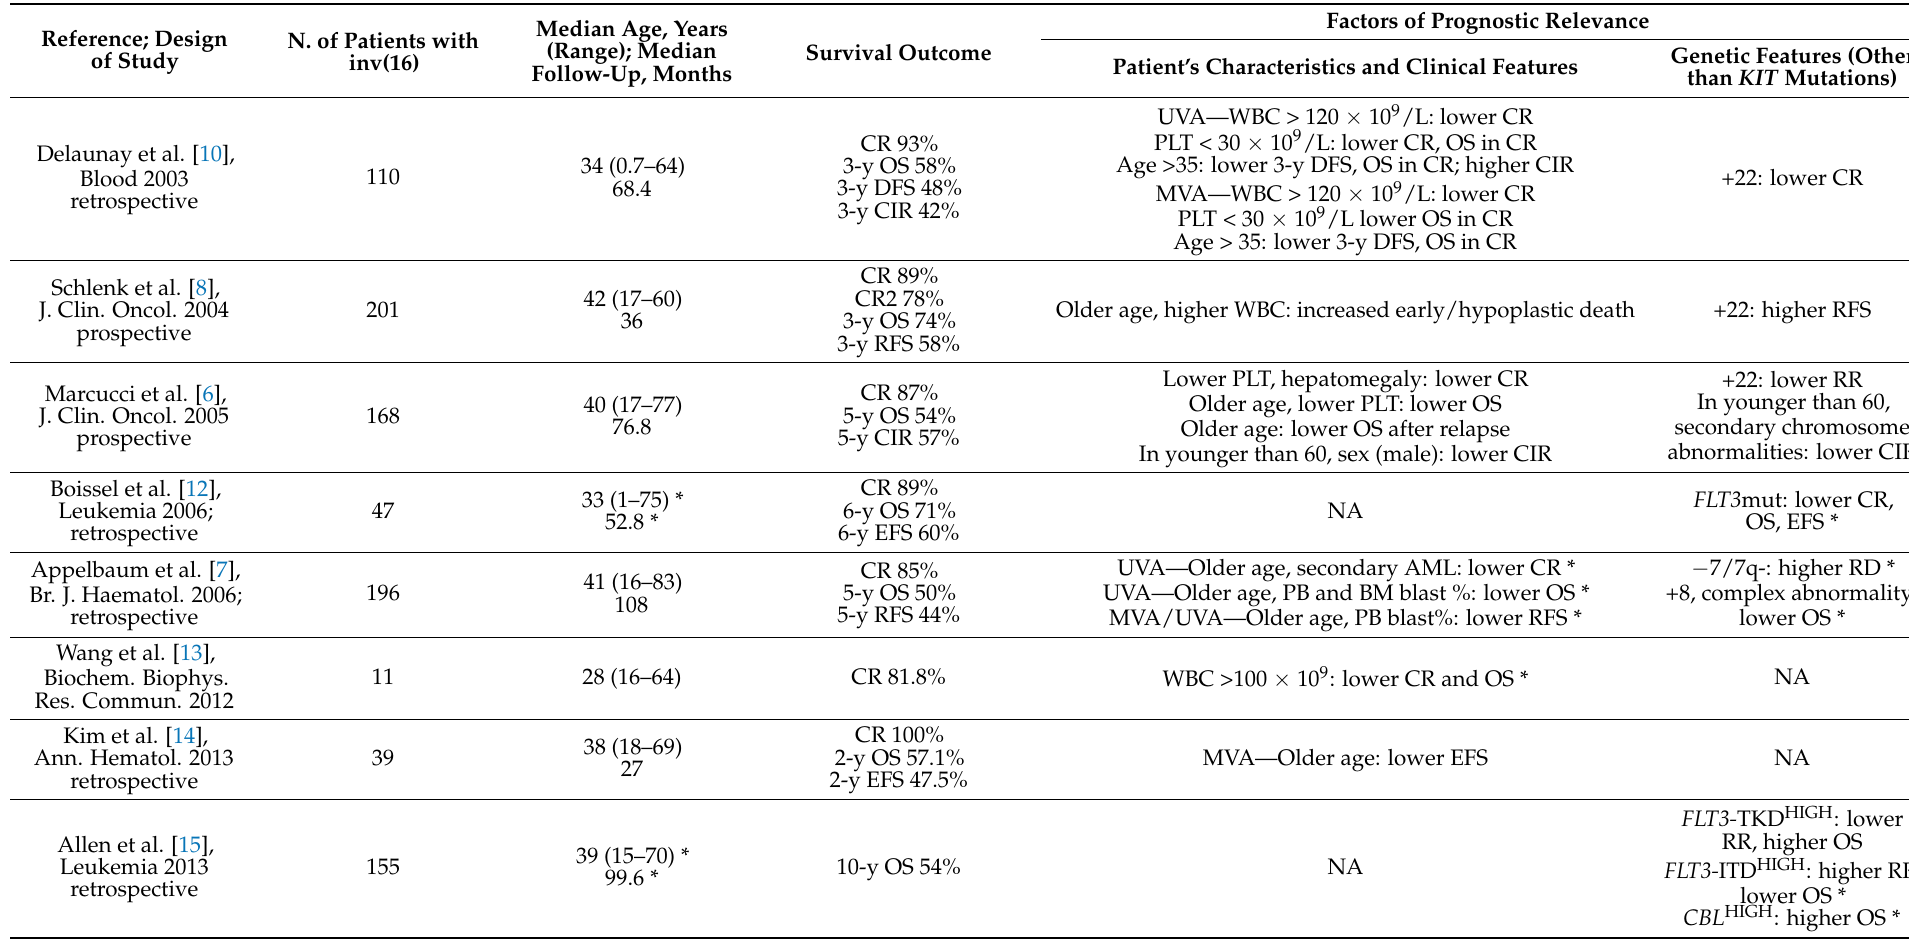
Table 1. Prognostic impact of clinical features at diagnosis in patients with AML showing